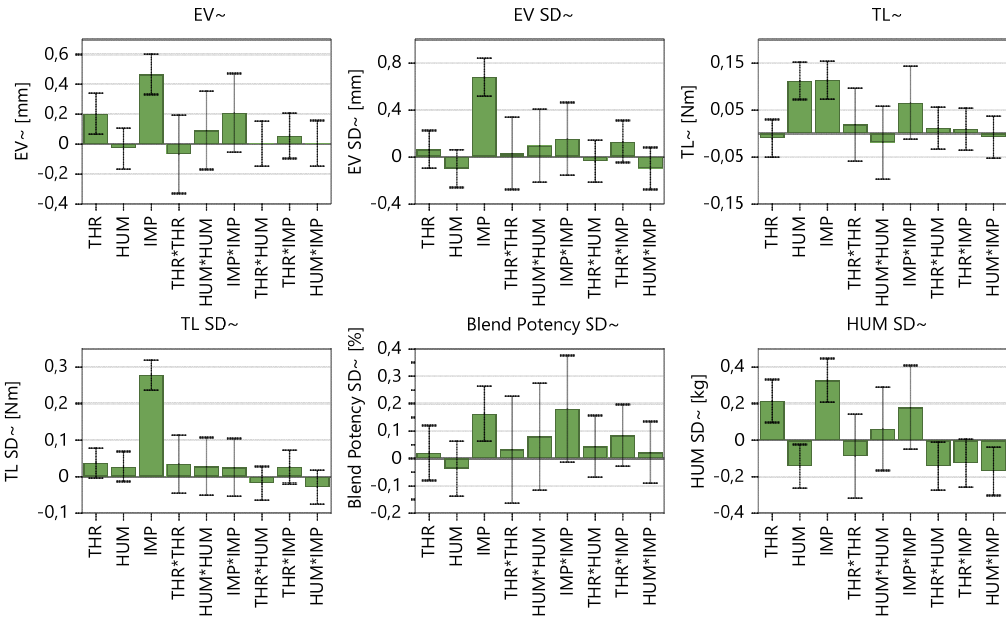
Figure 5. Coefficients plot of the impact of input variables on responses regarding the blending unit and uniformity of the blend. The 95% confidence interval is displayed as an error bar.